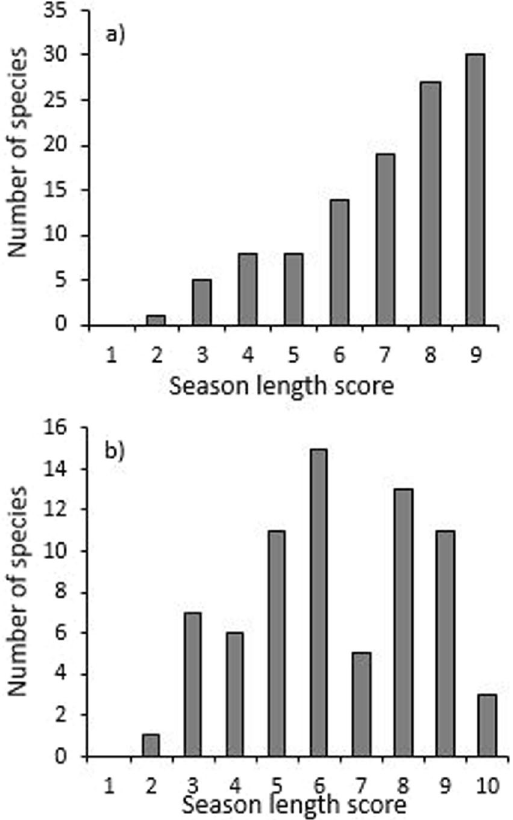
Figure 6. The frequency distribution of season-length scores across beetle species where n ≥ 10 individuals for ( a ) the Atherton transect, and ( b ) the Paluma